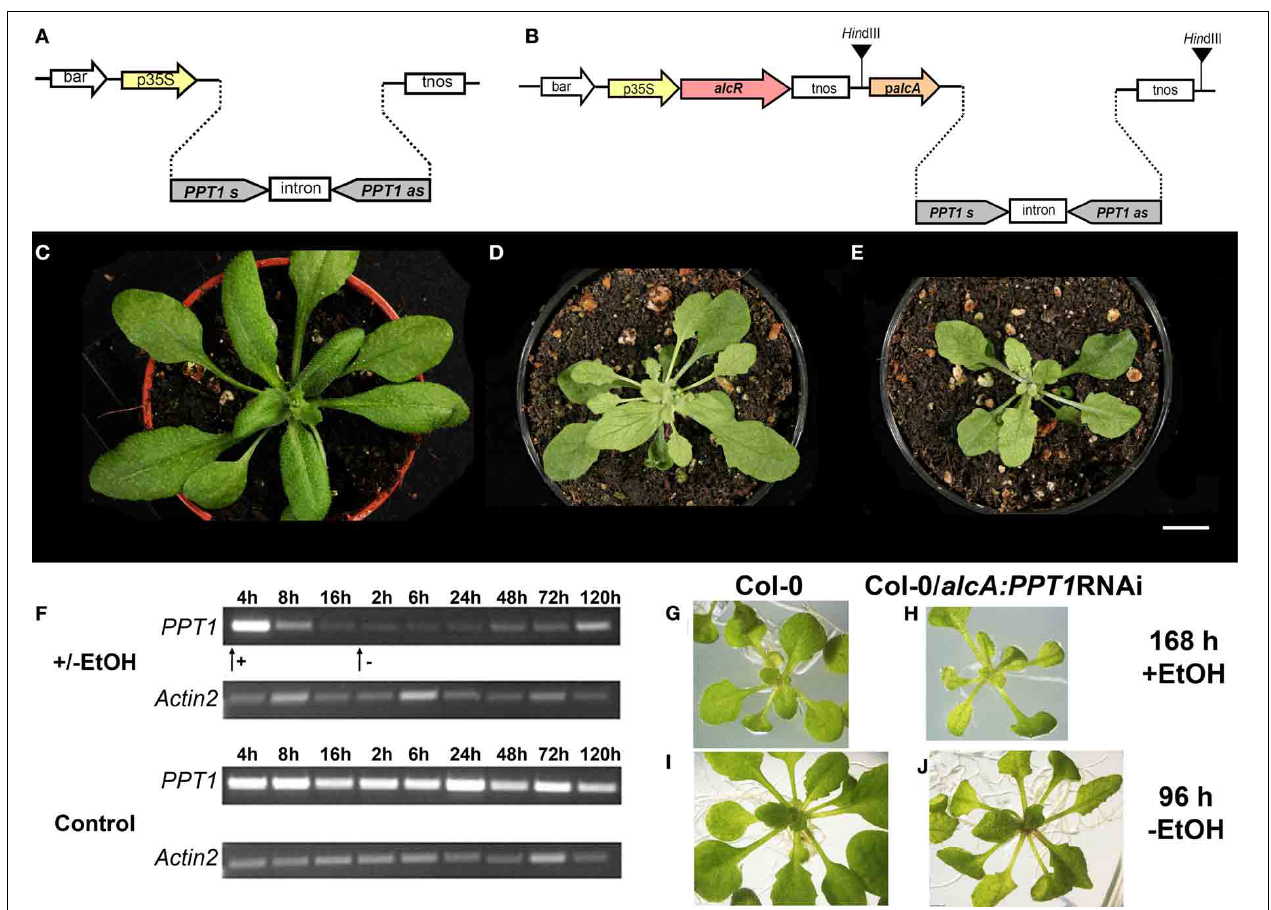
FIGURE 4 | Repression of PPT1 expression by a constitutive and inducible RNAi approach. Constructs are shown for a constitutive PPT1 RNAi expression driven by the CaMV 35S promoter (p35S) (A) or for the EtOH inducible alcR/alcA system (B) . Phenotypic appearance of Col-0 wild type (C) , and two lines expressing the PPT1RNAi construct constitutively [ (D) Col-0/ RNAi(1): alcA:PPT1 ; (E) Col-0/RNAi(2): alcA:PPT1 ].